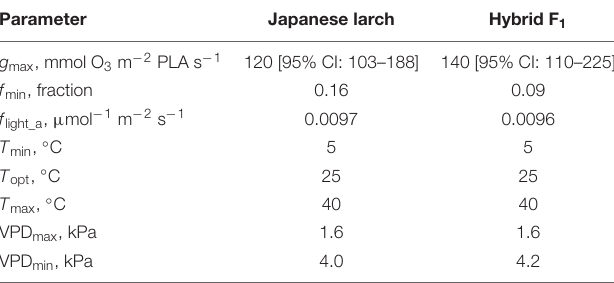
TABLE 2 | DO 3 SE model parameters for Japanese larch and hybrid F 1 , where g max is maximum stomatal conductance; f min is minimum stomatal conductance; f light_a is a parameter determining the shape of the hyperbolic relationship of stomatal response to light; T max , T opt , and T min are the maximum, optimal, and minimum temperatures, respectively, for calculating the function f temp that expresses the variation of g sto with temperature; VPD min and VPD max are the vapor pressure deficit for attaining minimum and maximum stomatal aperture, respectively ( f VPD ).